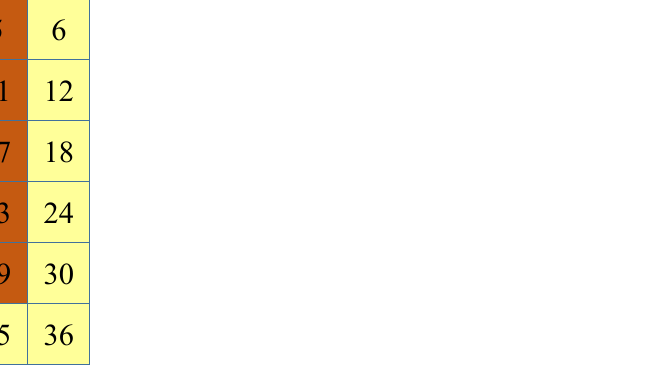
ange, red and yellow parts are scanned separately). red and yellow parts are scanned separately).